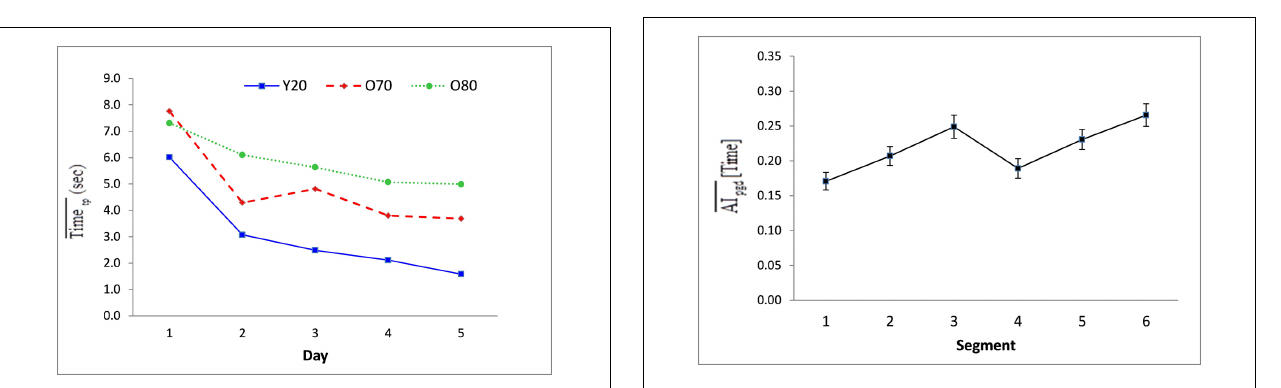
Proximity to the reverse circle (Segment 3) and end (Segment